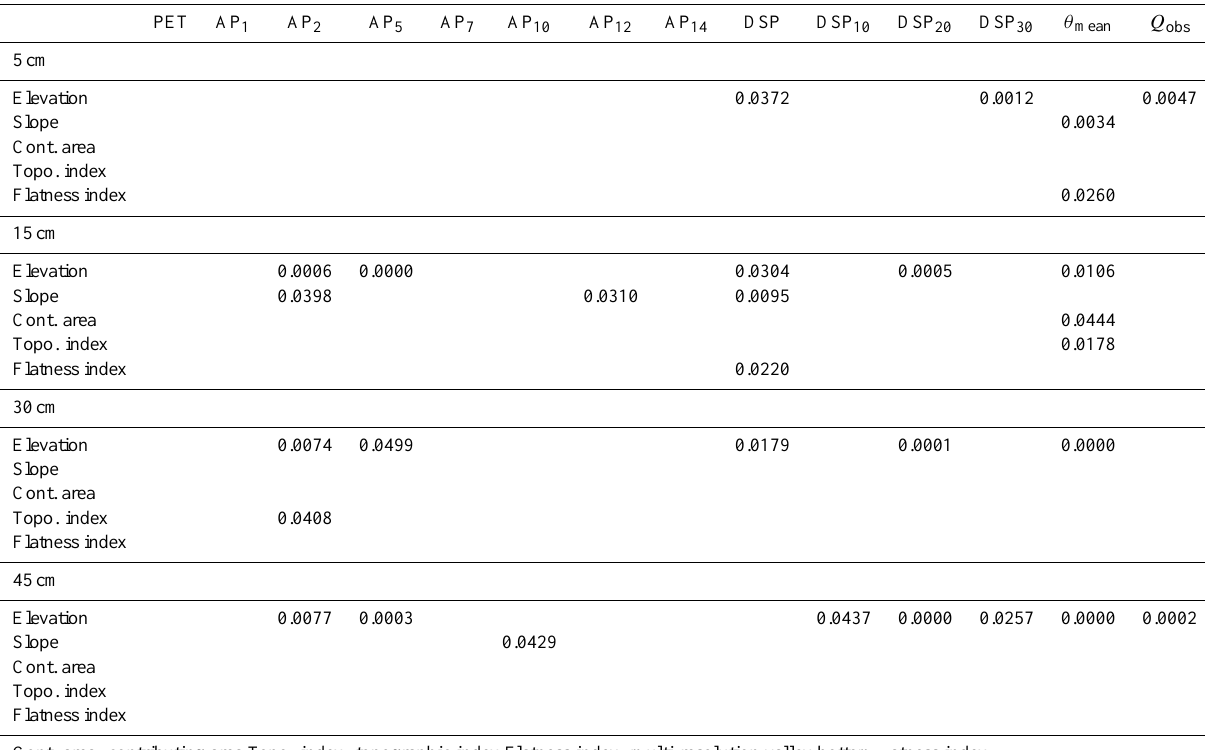
Table 4. Influence of catchment surface topography (rows) on the nature of the point-scale relationships between soil moisture content and various surrogates (columns). Reported p-values are significant and suggest that at least one relationship type is associated with a median value of the studied topographic variable that is significantly different from the